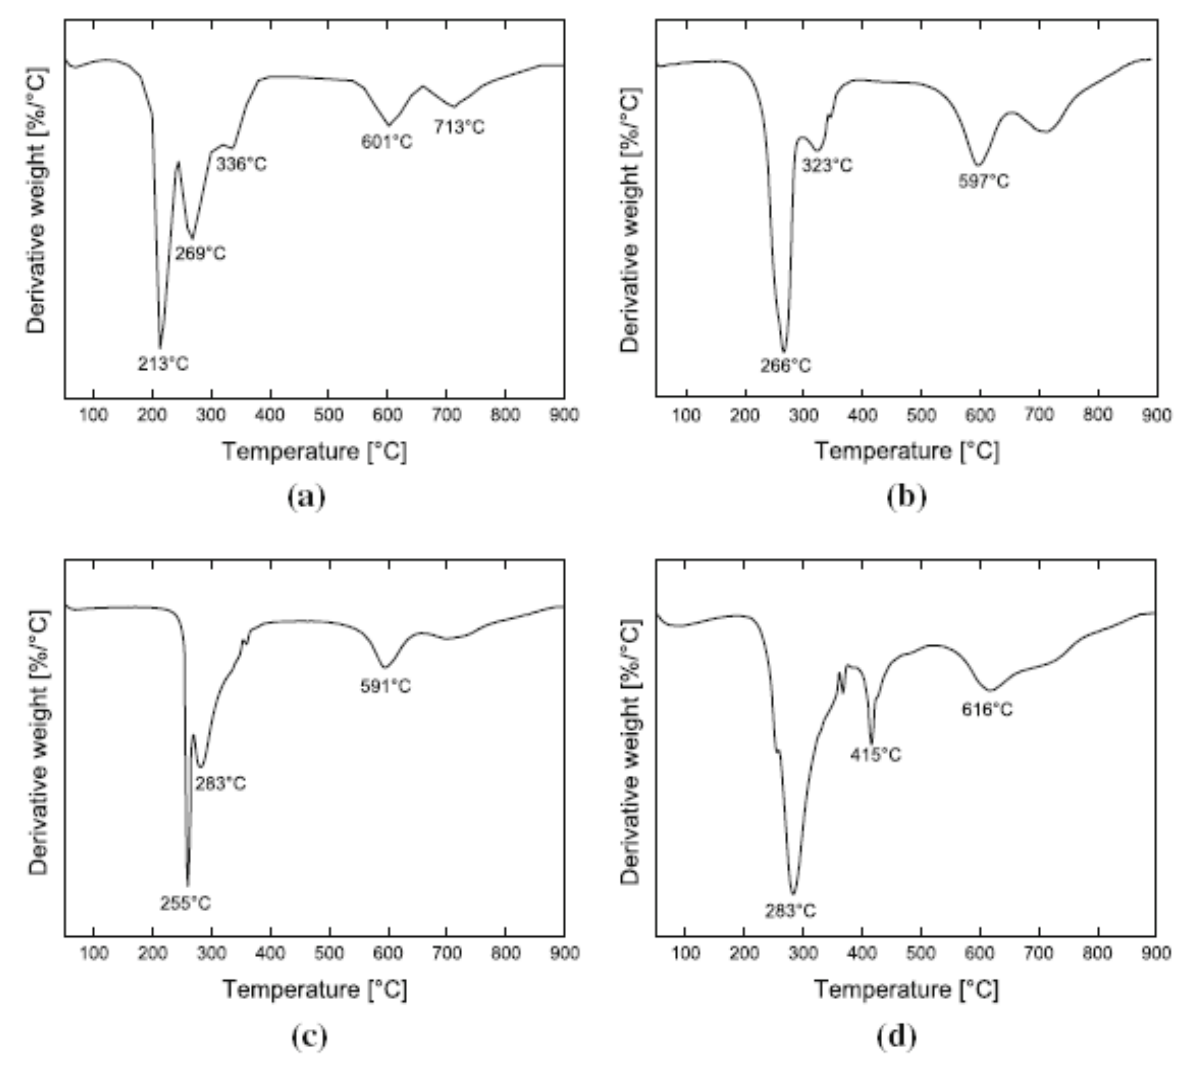
Figure 46. TGA thermograms of (a) commercially modified and (b) self prepared montmorillonite treated with benzylhexadecyldimethylammonium and (c) commercially modified and (d) self prepared montmorillonite treated with dioctadecyldimethyl- ammonium. Reproduced from reference